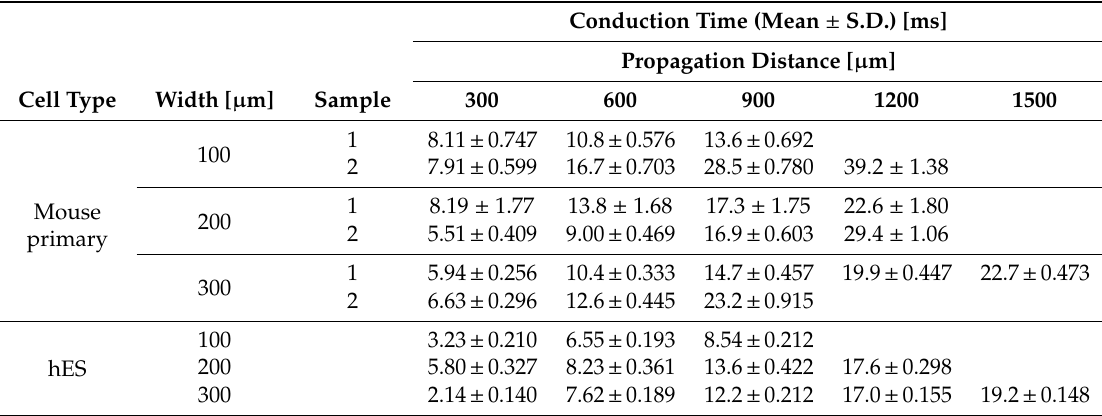
Table 1. The conduction time in cardiomyocyte